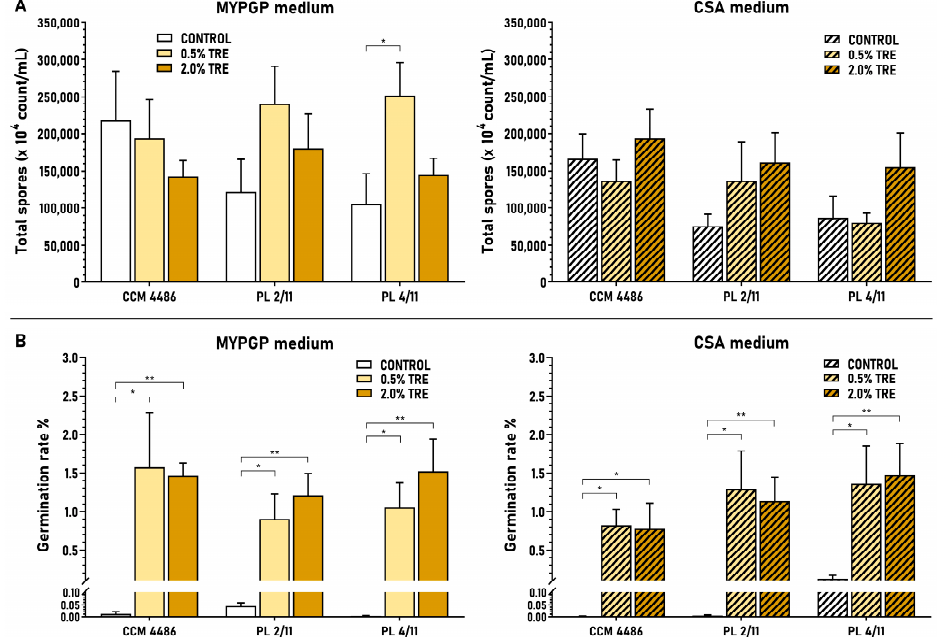
Figure 6. Effect of trehalose on total spore production ( A ) and spore germination ( B ) of P. larvae strains with an ERIC II genotype. Data are expressed as the mean ± SEM. Data showing statistical significance are marked (* p < 0.05, ** p < 0.01). Individual data sets represent results from 4–5 spore cultivation replicates. Spore germination rates were determined as the percentage of viable spores (grown on MYPGP plates supplemented with germination factors) to total spores (microscopically determined) present in the spore